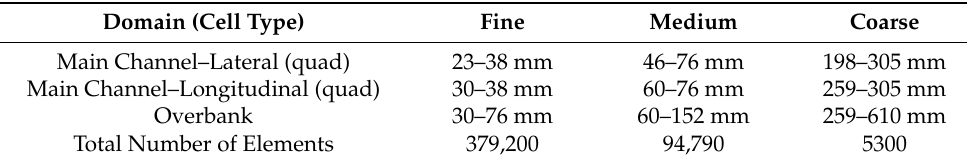
Table 6. Mesh Sizes Examined to Determine Grid